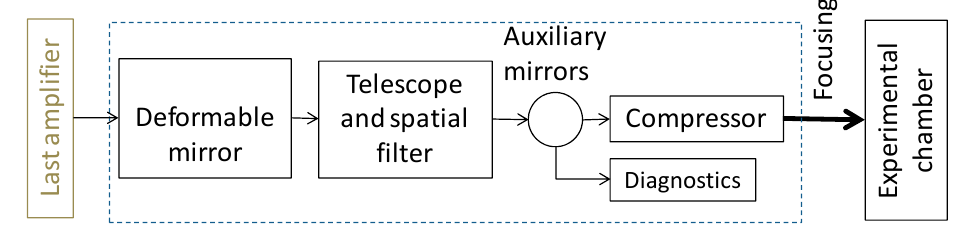
Figure 8. General transport and compression scheme.